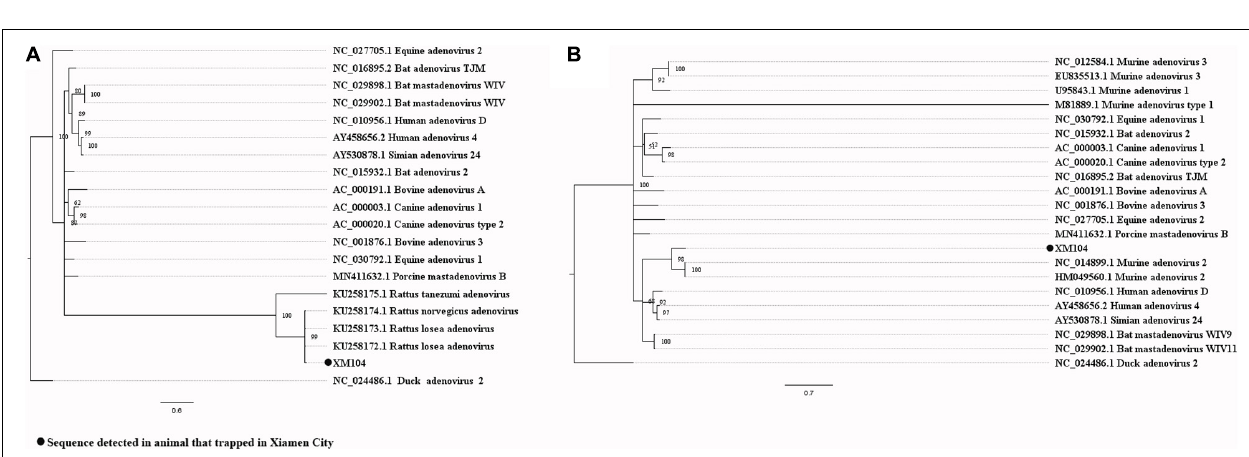
FIGURE 7 | (A) Phylogenetic tree constructed based on potential viral nucleotide sequence (451 bp, IE-2 protein gene) related to human herpesvirus 6A that obtained by using metagenomic sequencing (MrBayes, GTR + G + I nucleotide substitution model). A total of 10 representative sequences belonging to different species within genus Roseolovirus are included for comparison, and one sequences belonging to genus Iltovirus is set as outgroup. Percentages of the posterior probability (PP) values are indicated. (B) Phylogenetic tree constructed based on potential viral nucleotide sequence (245 bp) related to human herpesvirus 6B that obtained by using metagenomic sequencing (MrBayes, GTR + G + I nucleotide substitution model). A total of 12 representative sequences belonging to different species within genus Roseolovirus are included for comparison, and one sequences belonging to genus Iltovirus is set as outgroup. Percentages of the posterior probability (PP) values are indicated. (C) Phylogenetic tree constructed based on PCR-screened nucleotide sequences (144 bp) of herpesviruses from urban rats, bats, and house shrews (MrBayes, GTR + G + I nucleotide substitution model). A total of 23 representative sequences (DPOL gene region) are included for comparison, including 20 sequences belonging to different genera within subfamily Gammaherpesvirinae, one bat herpesvirus sequence, one shrew herpesvirus sequence, and one alphaherpesvirus sequence that is set as outgroup. Percentages of the posterior probability (PP) values are indicated.